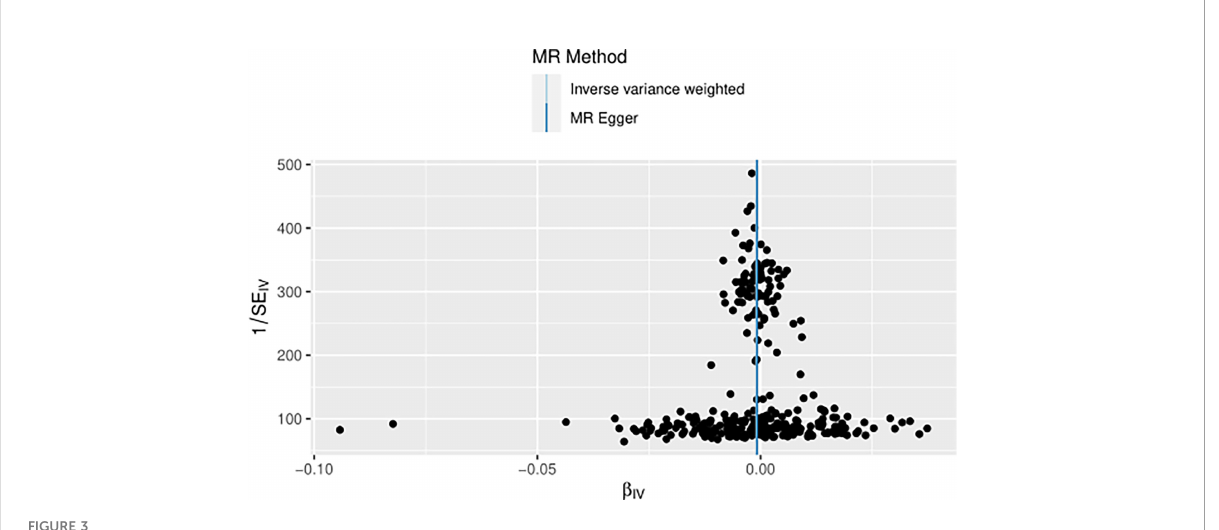
FIGURE 3 Funnel diagram of instrumental variable (TN ! BN).